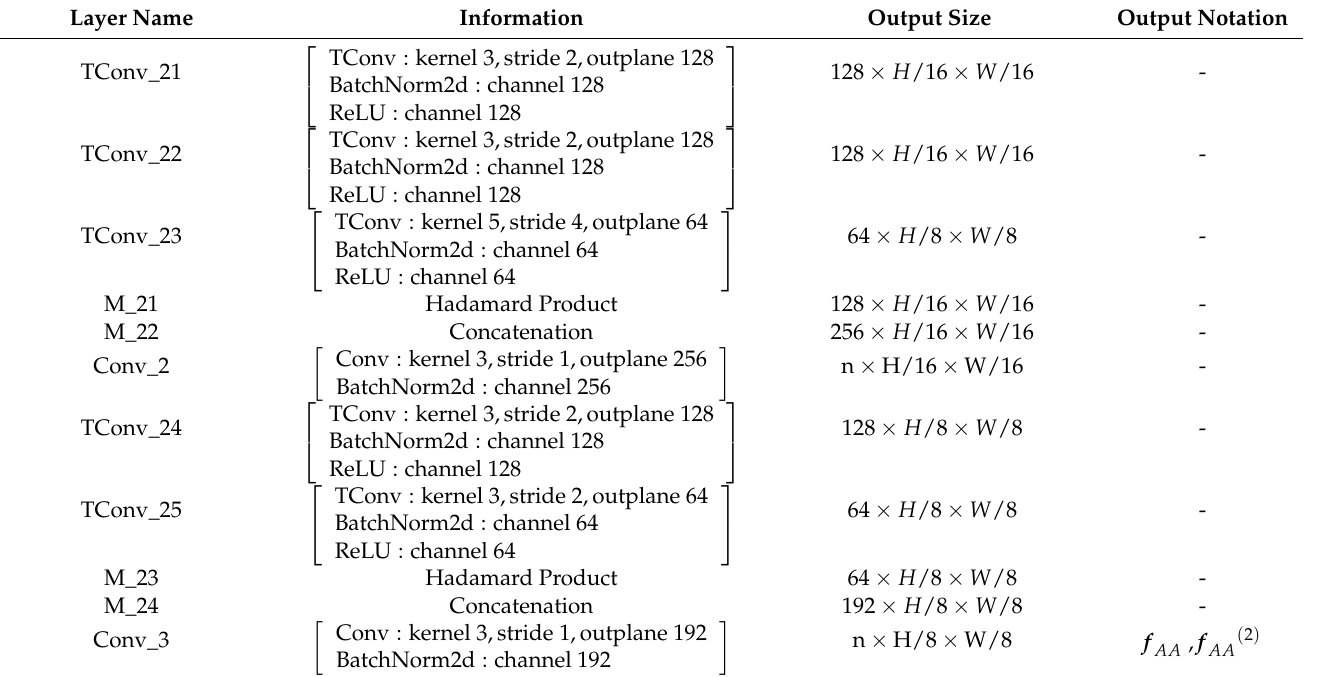
Table 2. Detailed layer information and feature maps size in Figure 2. The size of input image S I is 3 × H × W , and the size of output S p is n × H × W